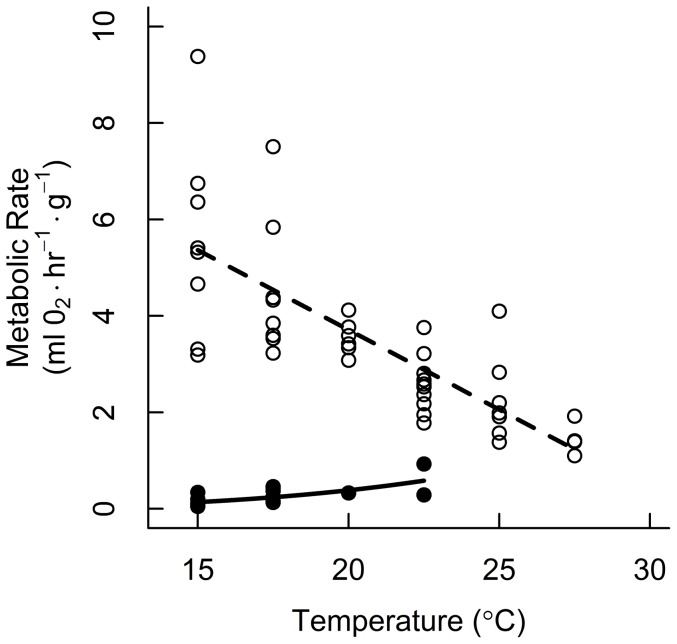
Torpid and euthermic metabolic rates measured by open flow respirometry.Silver-haired bats were held at a range of temperatures similar to local conditions. Open circles and dashed regression line indicate resting metabolic rate (RMR) and filled circles and solid regression line indicate torpid metabolic rate (TMR).